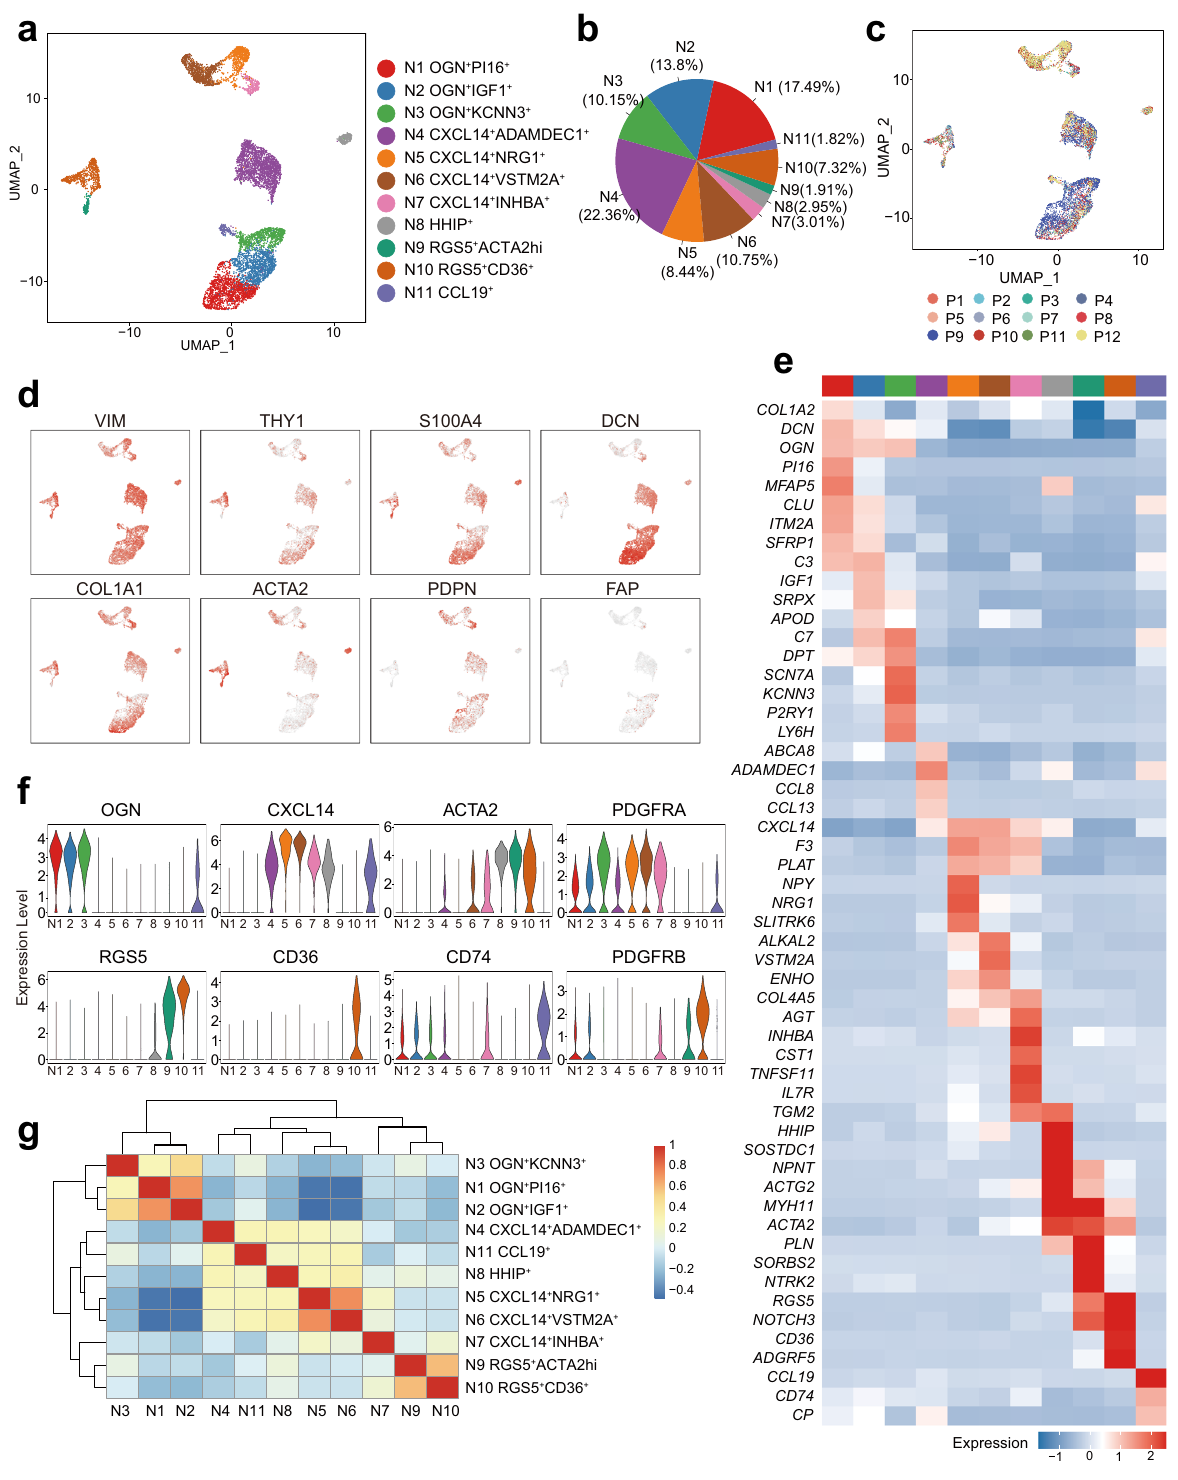
Fig. 1 scRNA-seq analysis de fi ned types of fi broblasts and myo fi broblasts in human colon mucosa. a UMAP projection of fi broblasts from normal colon mucosa, colored by inferred cluster identity. b Proportions of the clusters in all fi broblasts. c UMAP projection of normal colon mucosa fi broblasts colored according to the patients (labeled P1 to P12, n = 12). d UMAP Feature plots of the expression distribution of classical fi broblast markers . e Heatmap showing the scaled expression of marker genes in each cluster of mucosal fi broblasts. f Violin plots showing selected distinct markers of clusters. g Heatmap of Pearson correlation coef fi cients between the normal colon mucosa fi broblast clusters. The dendrogram shows the inferred hierarchy of clusters according to the Pearson correlation coef fi cients of the average expression of marker genes among clusters. The color scale shows the Pearson correlation coef fi